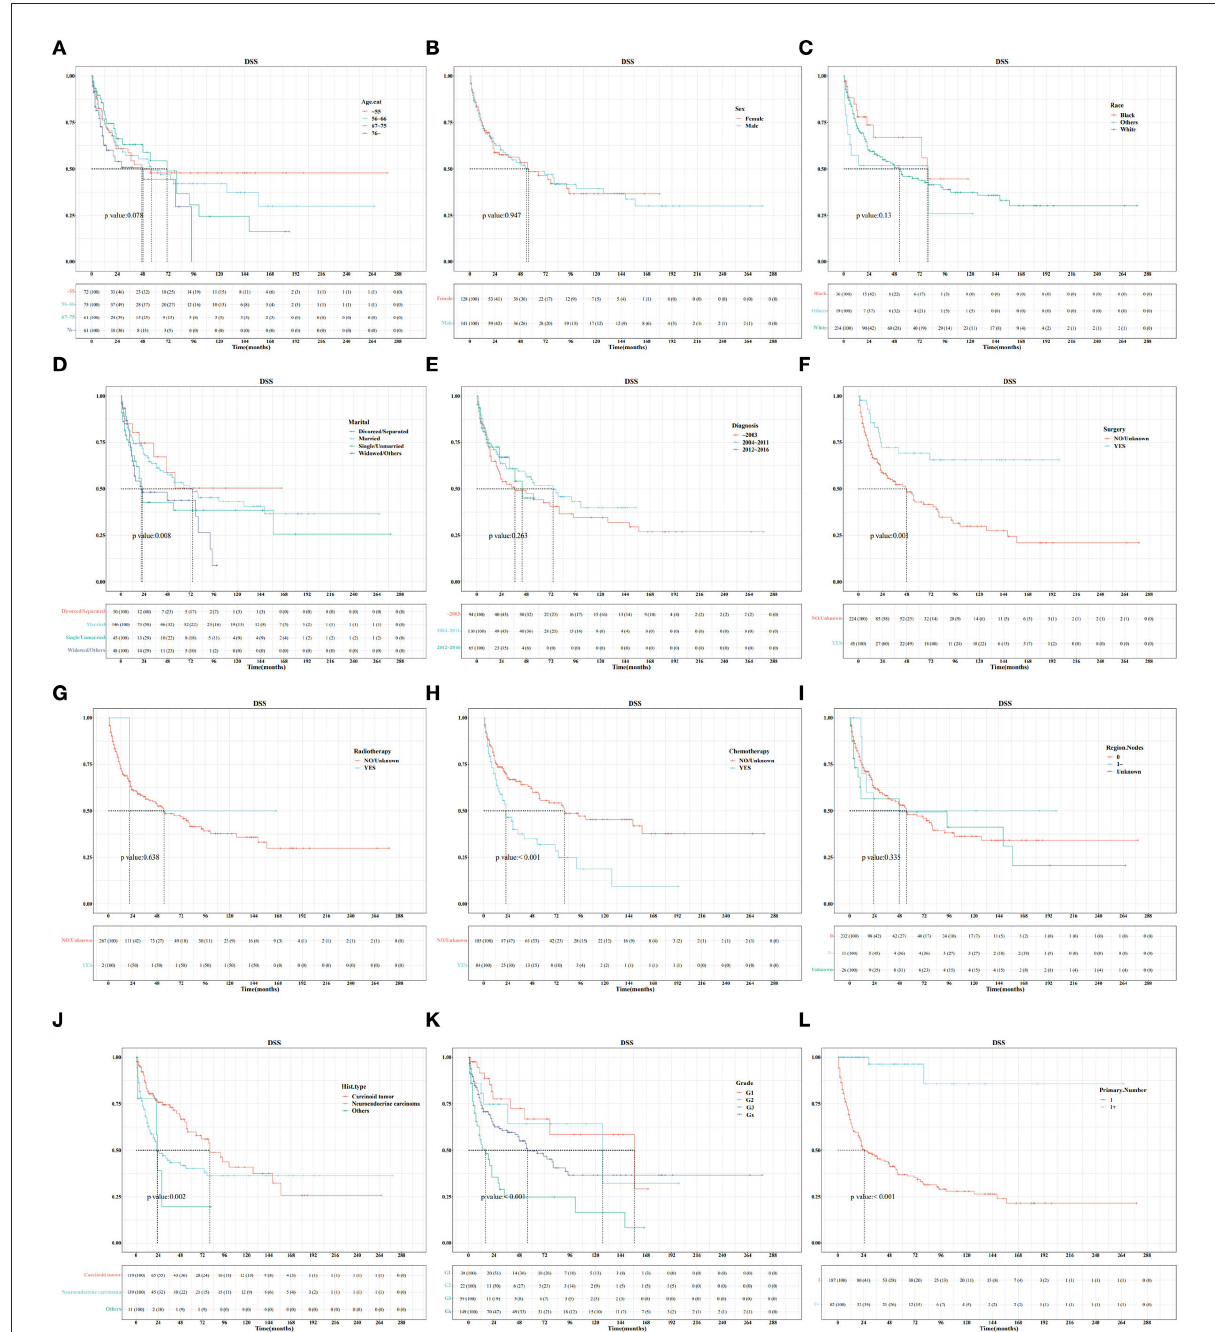
FIGURE2 Survival curve analysis of the influence of the main variables on the DSS of patients with primary hepatic neuroendocrine tumor (PHNET) in the training set. (A) age; (B) sex; (C) race; (D) marital status; (E) year of diagnosis; (F) surgery; (G) radiotherapy; (H) chemotherapy; (I) number of regional lymph nodes; (J) histological type; (K) grade; and (L) number of primary malignancies.